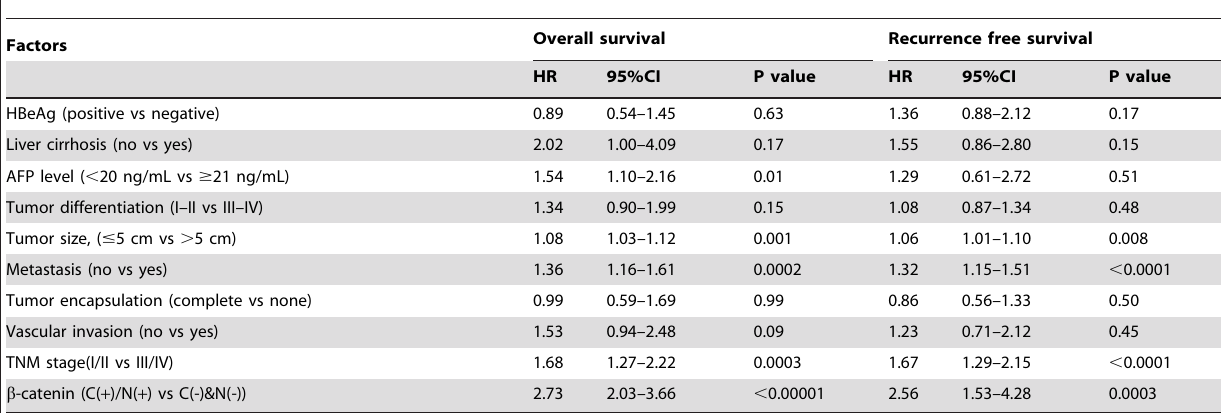
Table 5. Multivariate analyses of factors associated with survival and